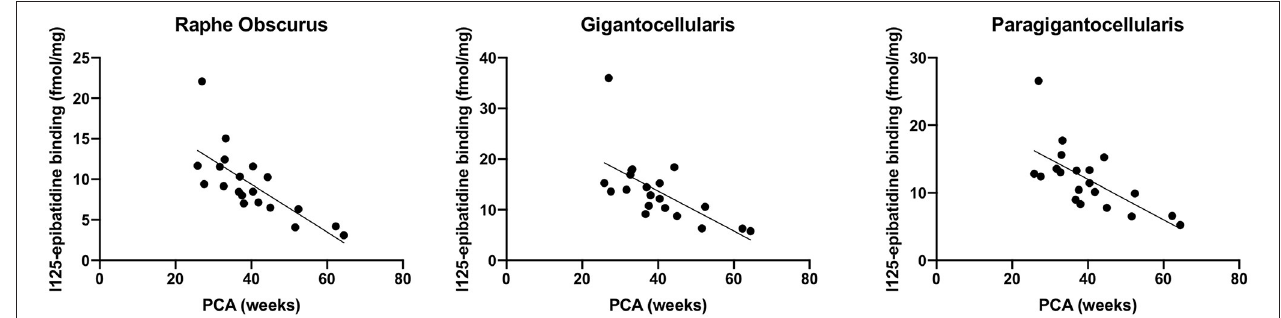
FIGURE 2 | Developmental decrease in 125 I-epibatidine binding in the rostral medulla. Combined pre- and post-KCOD controls show a decrease in 125 I-epibatidine binding in nuclei of the rostral medulla. This relationship is illustrated in the RO ( p = 0.0002), GC ( p = 0.002), and PGCL ( p = 0.001).